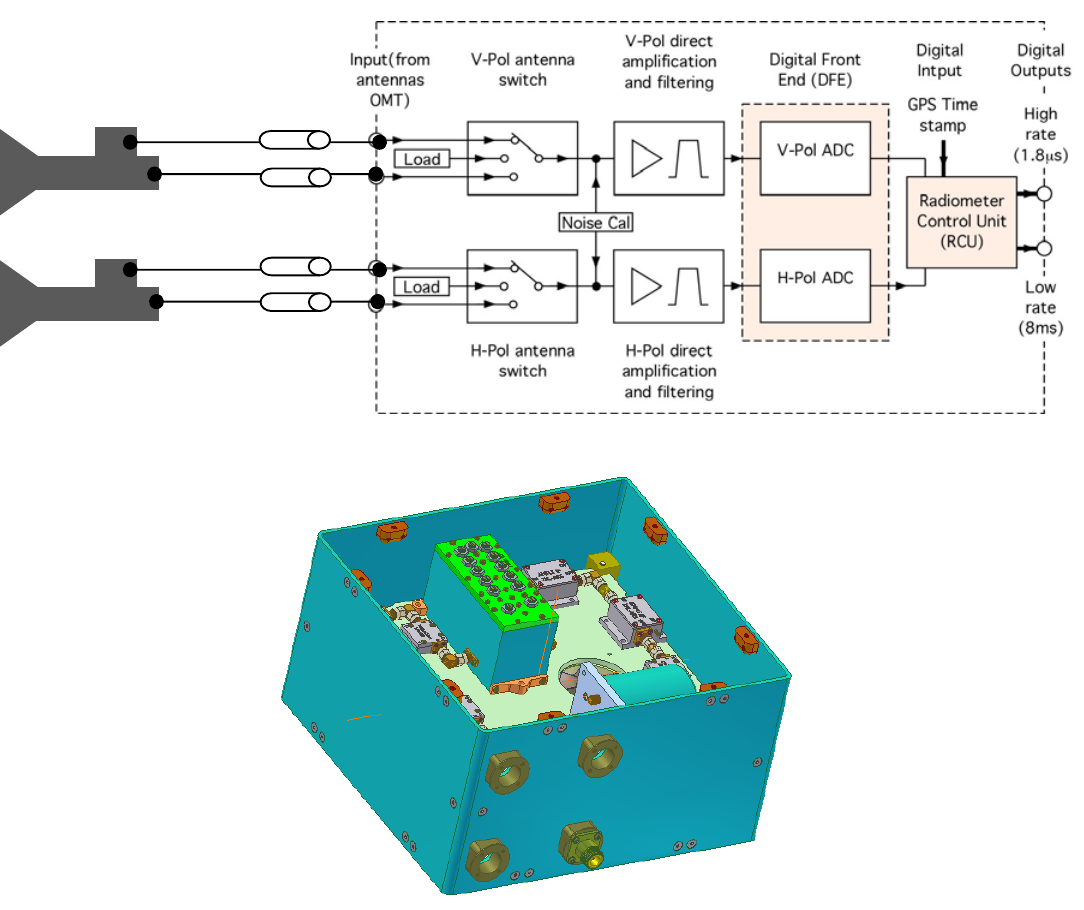
Figure 1. Block diagram of the antenna and receiver